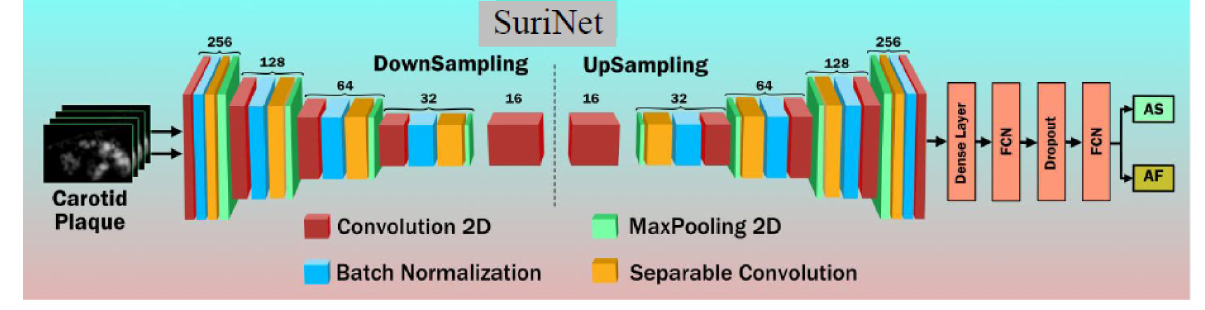
Figure A8. SuriNet architecture